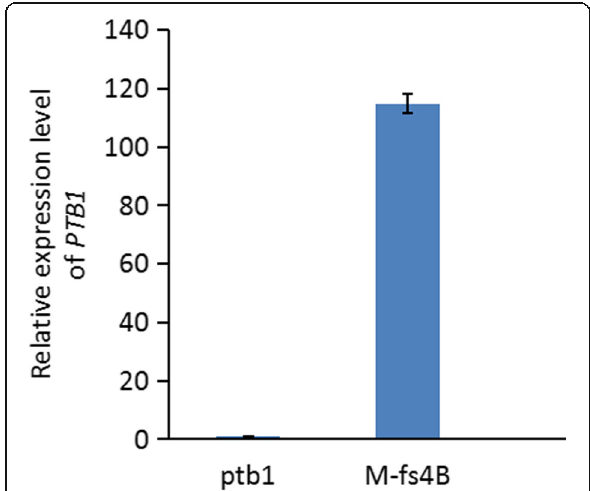
Fig. 4 Differential expression level of the PTB1 gene between the transgenic line M-fs4B and ptb1 mutant. The relative expression level of the PTB1 gene was determined using q-PCR analysis with RNA isolated from the pistil of the transgenic line M-fs4B and ptb1 mutant. Relative expression levels were measured as the mean ± s.e.m. ( n = 3). All P values are based on two-tailed t -tests